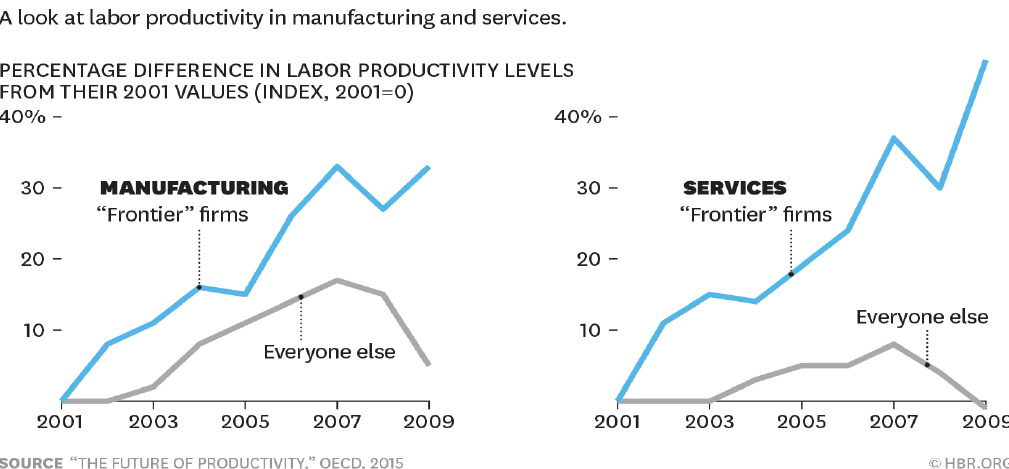
Figure 3. Frontier firms vs. others